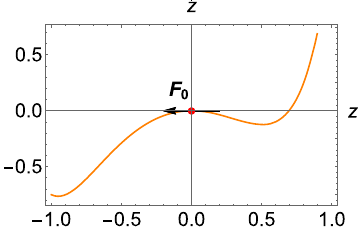
Fig. 8 One dimensional flow for (B.27) for z ∈ [− 1 , 1 ] the origin is